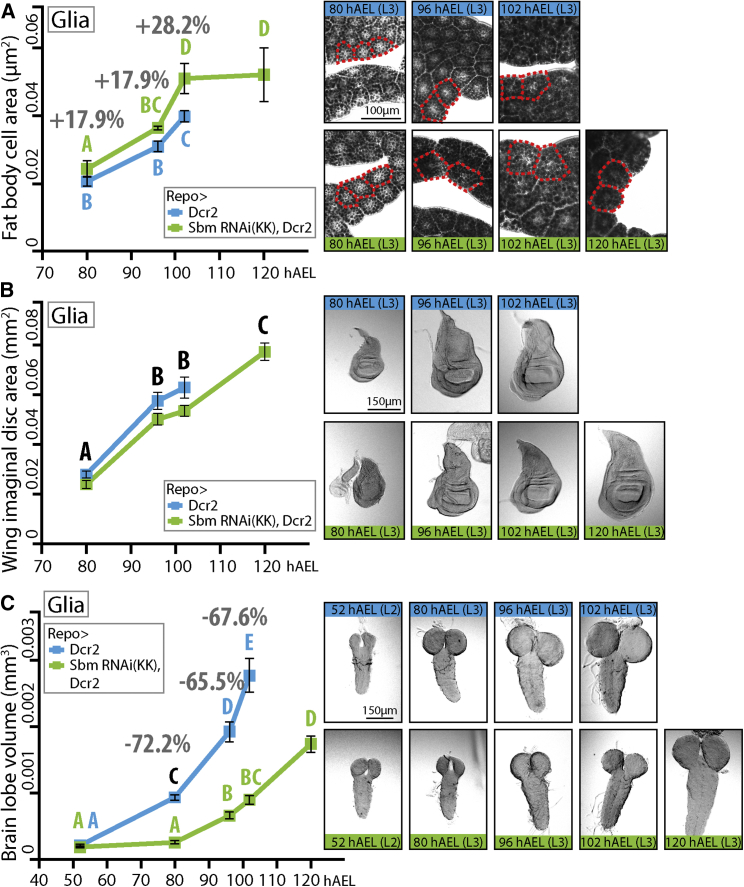
Effects of sbm Downregulation in Glia on Various Tissue Growth(A) Fat body cell area (μm2) through time and representative pictures of fat bodies stained with Sudan black to show fat accumulation (the red broken line exemplifies some measured cells in each picture) (two-way ANOVA and Duncan post-test, p < 0.01, F = 6.26; n = 4–5.)(B) Wing imaginal disc area (mm2) through time and representative pictures (Two-Way ANOVA with a Duncan Post-Test, interaction between the variables time and genotype is not significant so only statistical differences between time points is shown in the graph, p < 0.0001, F = 123.13; n = 11–15).(C) Estimation of larval single brain lobe volume (mm3) through time and representative pictures (two-way ANOVA with a Tukey post-test, p < 0.0001, F = 22.55; DMS = 0.34; n = 4–5.)In all statistical analyses, data were transformed to natural logarithm (ln) to fulfill the test criteria. In all graphs, points with different letters signify that they are significantly different (p < 0.05). Data represent mean ± SEM; the percentages above points indicate the difference in respect to the control. hAEL, hours after egg laying.